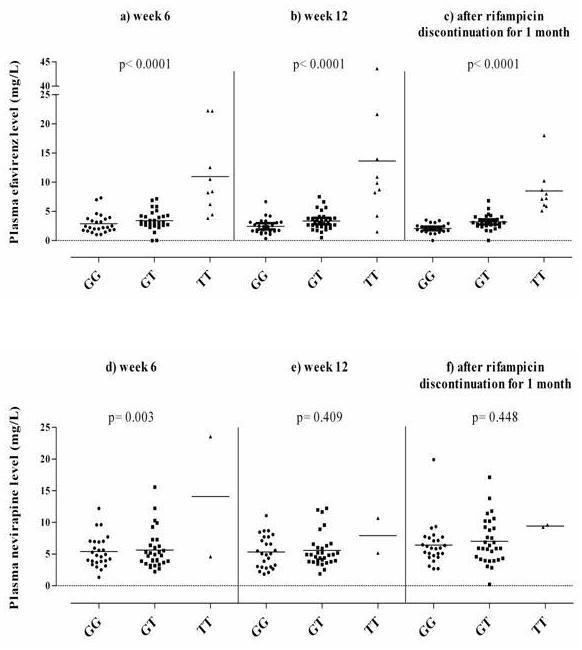
Mean plasma efavirenz and nevirapine concentrations in HIV/TB adults with different genotypes of CYP2B6-G516T polymorphism. The scatter diagram of plasma efavirenz (Fig.1a, b, c) and nevirapine distribution (Fig. 1d, e, f) at weeks 6 and 12 of ART and 1 month after rifampicin discontinuation. The numbers of GG, GT and TT genotype patients were 25, 31 and 9 in efavirenz group and 26, 31, 2 in nevirapine group.